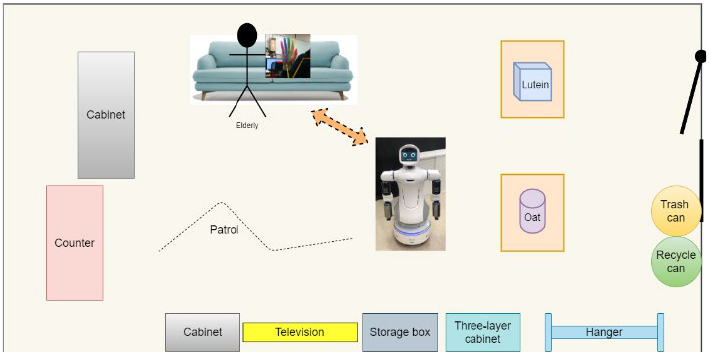
Figure 15. Experimental scenario of long-term care centers.